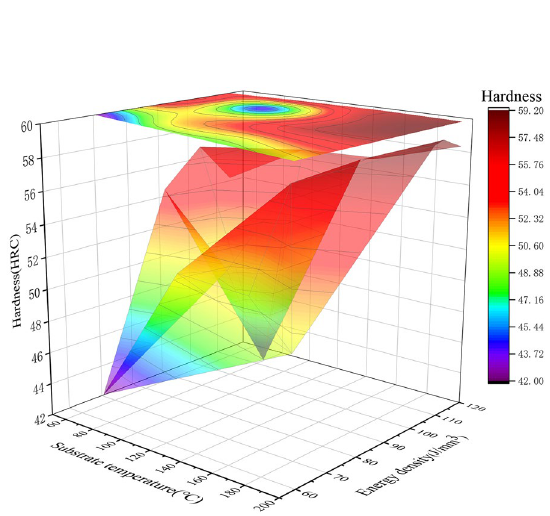
Figure 7 Effect of energy density and substrate temperature on